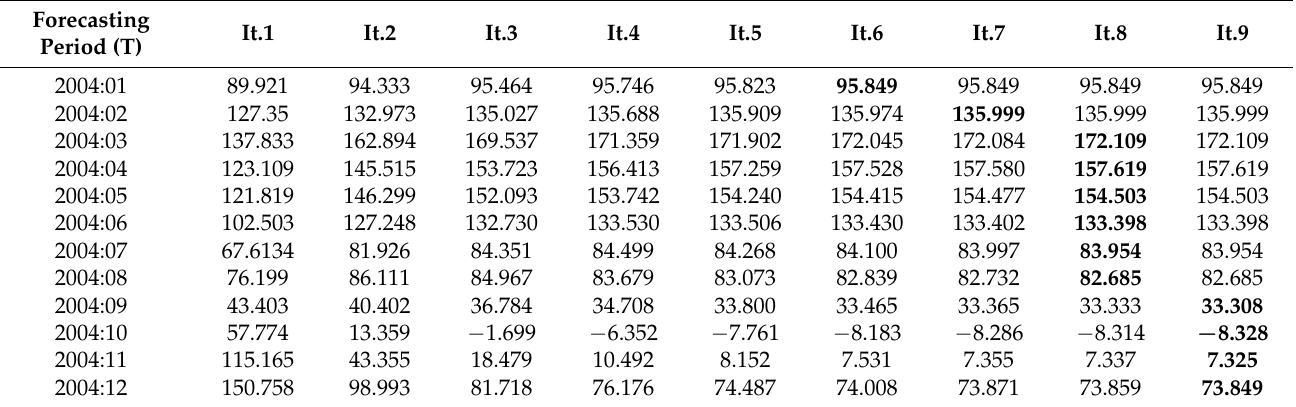
Table 6. Monthly forecasts of the company’s financial liquidity (LIQ Tp ) for the year 2004 in subsequent